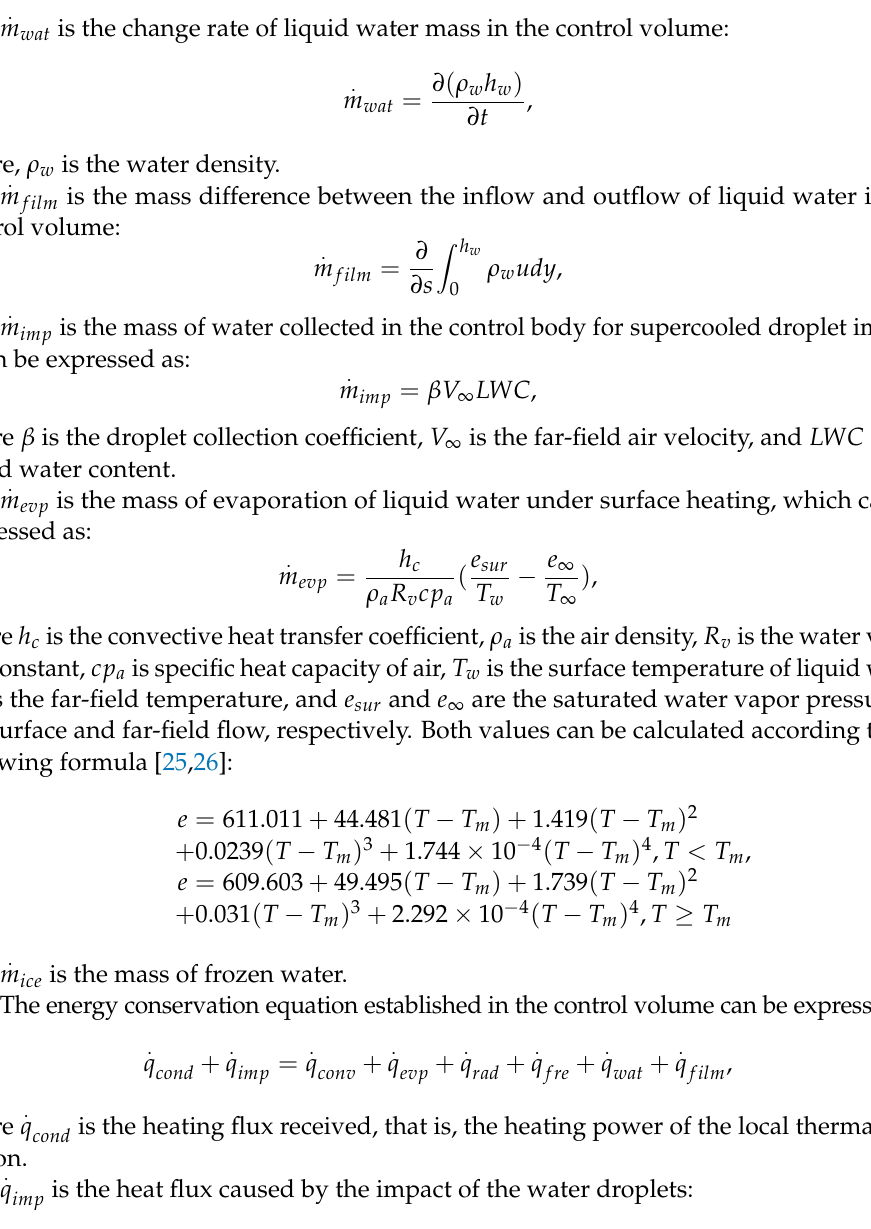
Figure 1. Diagram of mass and heat transfer of control volume.